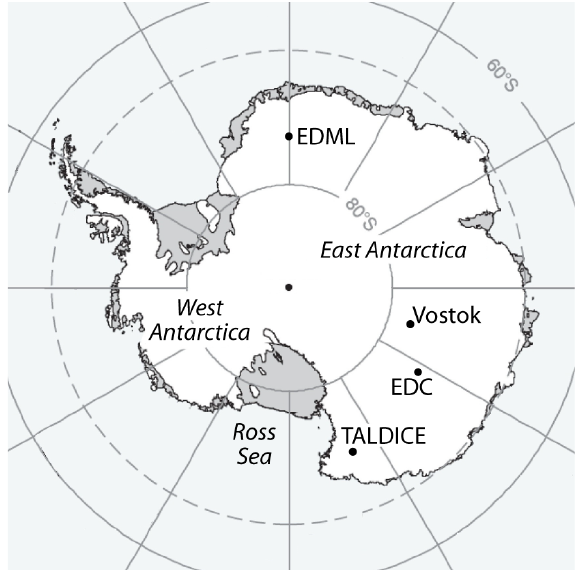
Fig. 1. Map of the Antarctic ice sheet. The four Antarctic drilling sites discussed in this work are indicated. One is located in the At- lantic sector (EDML) and, thus, closer to the southern South Amer- ican continental dust source than EDC and Vostok, both being lo- cated in the Indian Ocean sector. The fourth drilling site, TALDICE, is at a more coastal site close to the Ross Sea and, therefore also in- fluenced by local source regions especially during warm